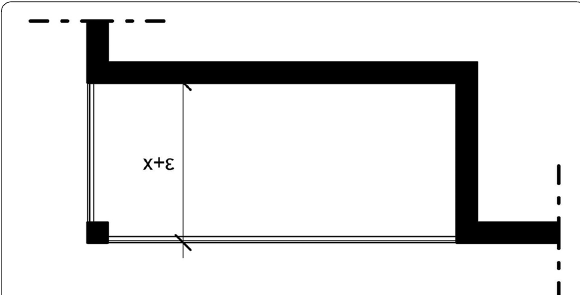
Fig. 4 A loggia opened on two sides, according to the normative scheme used for the case studies, does not count as